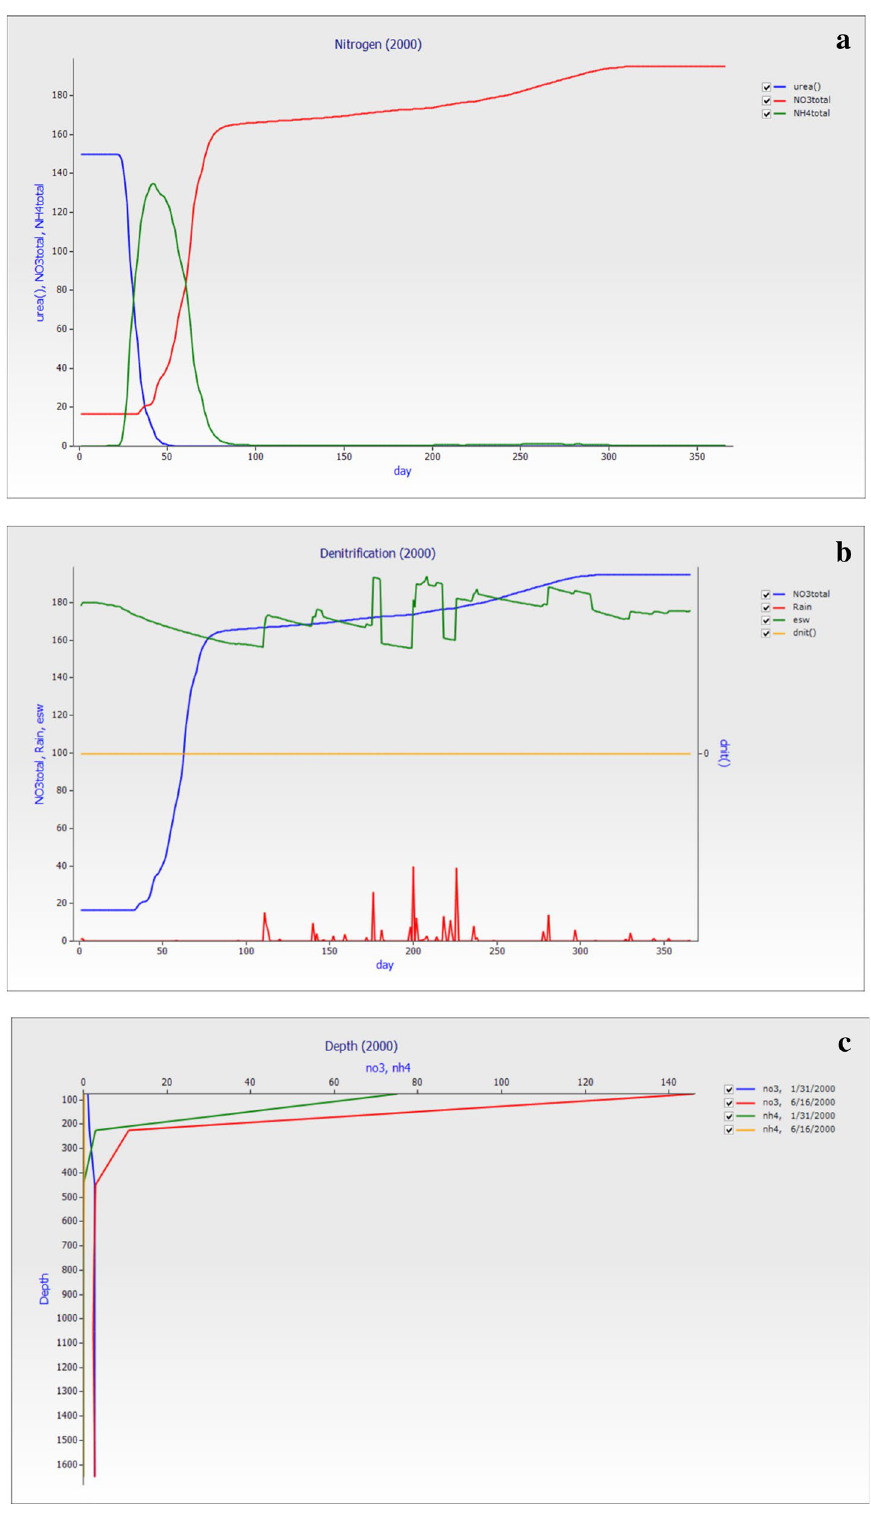
Figure 7. The graph of the year 2000 ( a ) the graph between Rain versus urea, Total NO 3− –N and NH 4+ –N and days of the year ( b ) day versus Total NO 3− –N, Rain, Essential soil water (esw) and Total NH 4+ –N while ( c ) The losses (NO 3− –N and NH 4+ –N) with different depth indicated that the losses of NO 3− –N losses depend on the rainfall occasions at other dates of the year